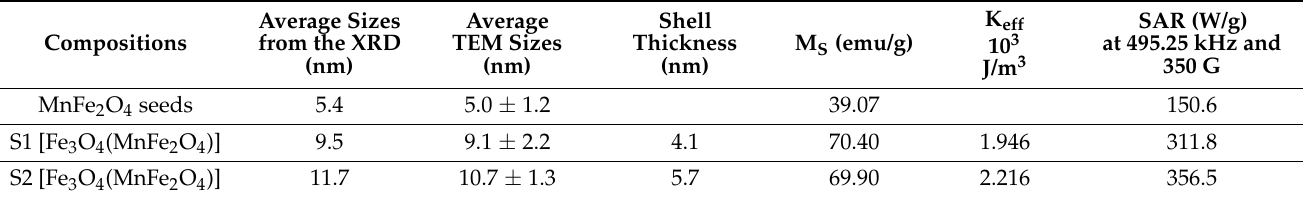
Figure 5. MH plots of the S1 and S2 core-shell nanoparticles at 300 K. Table 3. List of the average sizes, effective anisotropy, and SAR values of the MnFe 2 O 4 seed and core-shell nanoparticles.